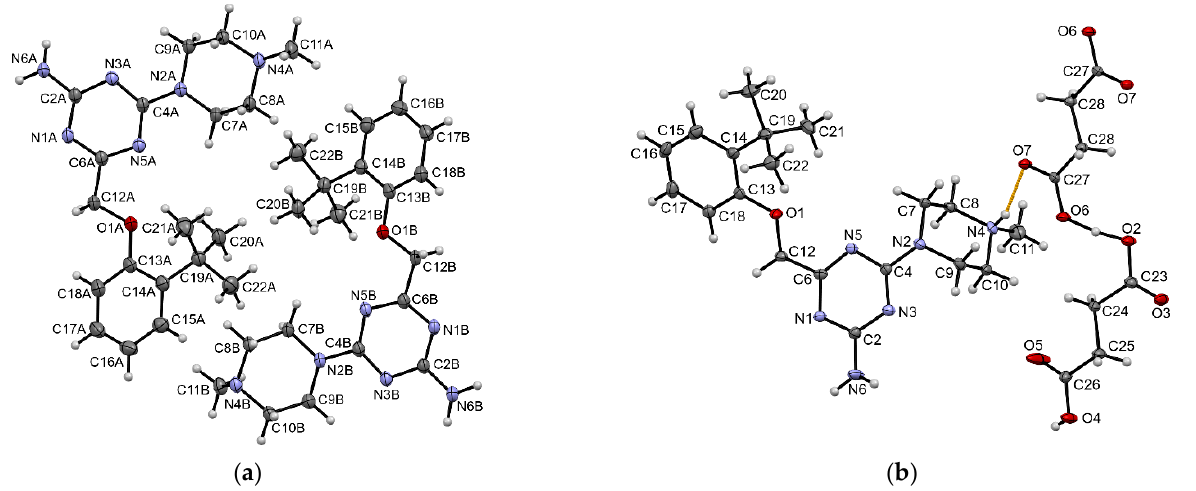
Figure 4. The contents of the asymmetric units of ( a ) compound 3 and ( b ) compound 3-SA (the whole anion is drawn), showing the atom-numbering schemes. Displacement ellipsoids are drawn at the 50% probability level. The charge-assisted hydrogen bond in compound 3-SA is depicted in orange.